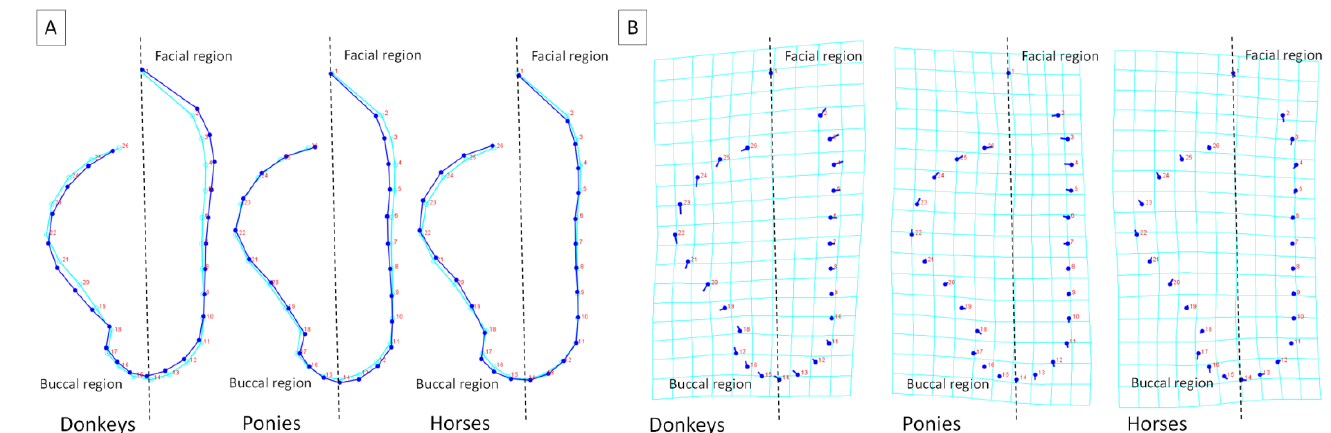
Figure 5. Average observations of the equid head shapes for donkeys, ponies, and horses, represented by ( A ) wireframe graphs and ( B ) transformation grids. On the wireframe graphs, light blue landmarks and curves represent the consensus animal’s head shape and the dark blue landmarks and curves represent the average observations for the subsequent groups. On the transformation grid, the dark blue landmarks represent the consensus animal’s head shape, while dark blue lines represent the average observations for subsequent groups. Dashed lines indicate the boundaries between regions.